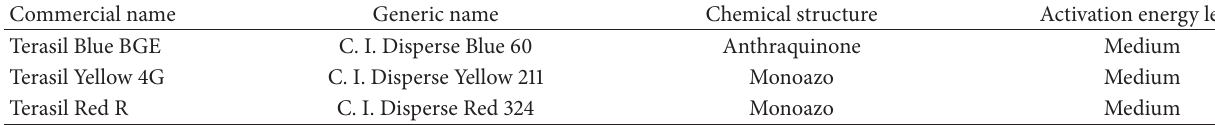
Table 2: Characteristics of disperse dyestuffs used in the experiment.